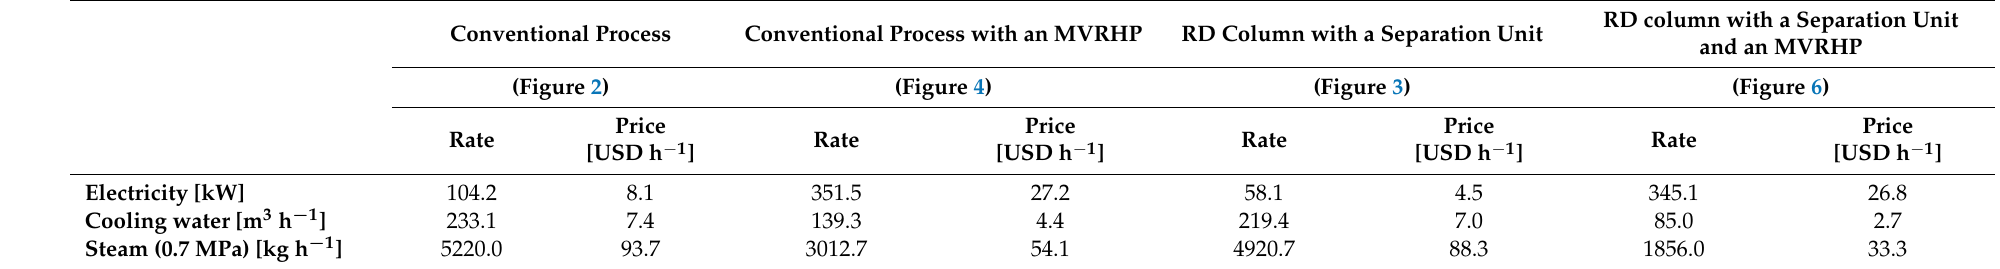
Table 6. Comparison of utility consumption: originally designed processes and processes using MVRHP.